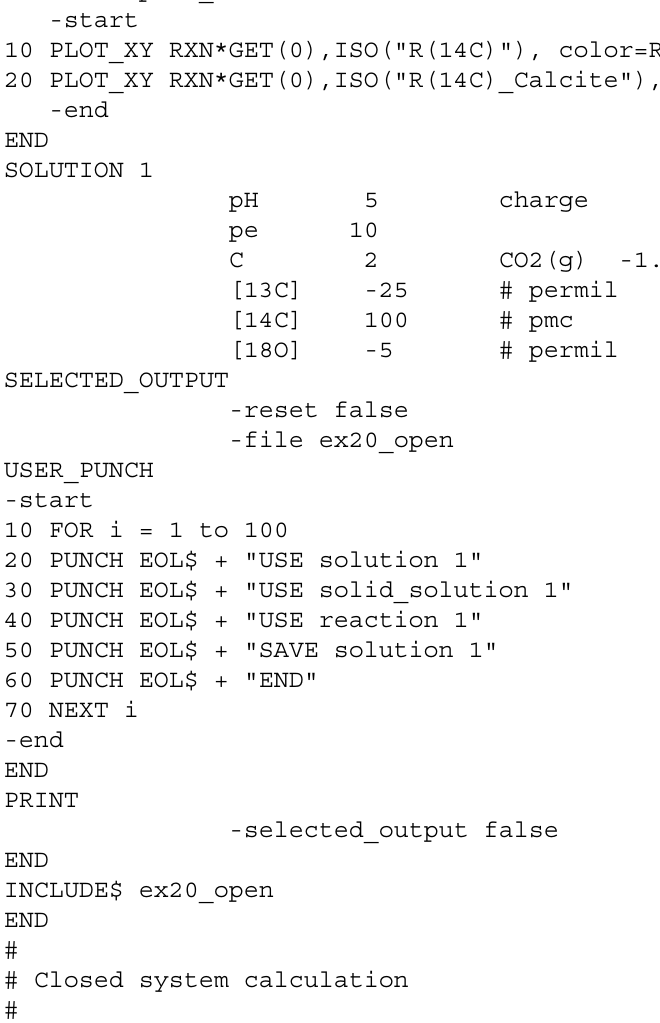
-headings Open--Dissolved